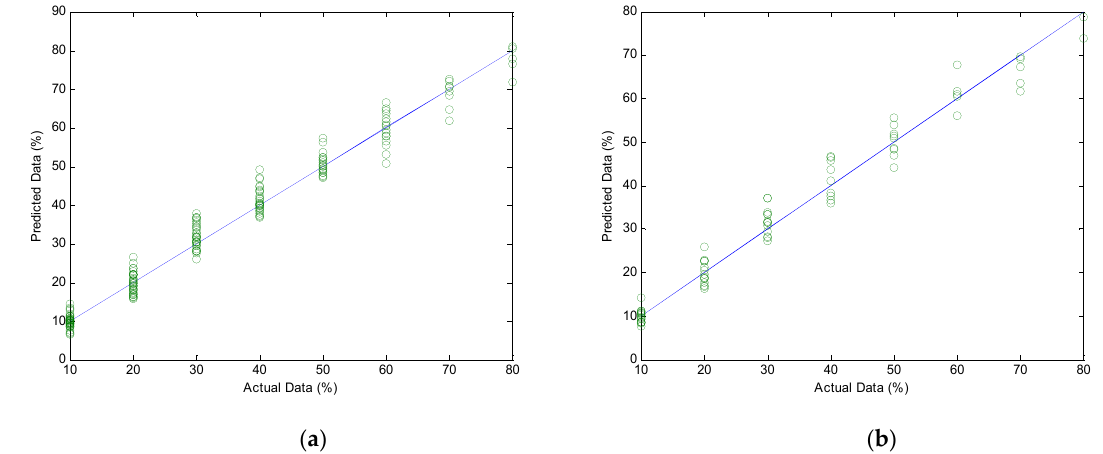
Figure 10. Recorded counts under photo peaks of 133 Ba in the second detector versus gas, oil, and water volume fraction: ( a ) scale thickness is 0, ( b ) scale thickness is 3 cm. Regression diagrams of actual data and predicted data using presented MLP–LM models are shown in Figures 11 and 12. In Table 1, data number, scale layer thickness, actual outputs, and measured outputs for test data set are tabulated.